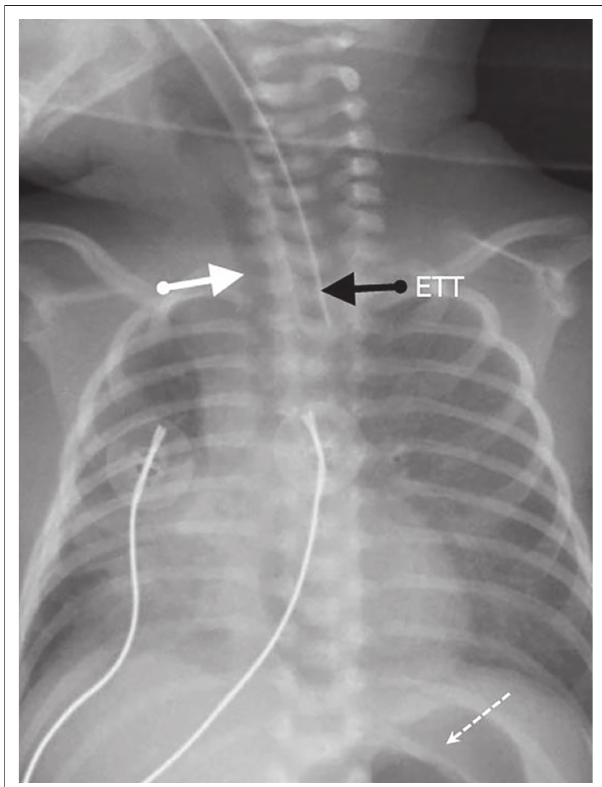
FIGURE 9: The ETT is positioned in the oesophagus. The trachea (white arrow) is visible to the right of the ETT. Secondary to oesophageal intubation there is dilatation of the stomach (dotted arrow) and distal oesophagus.